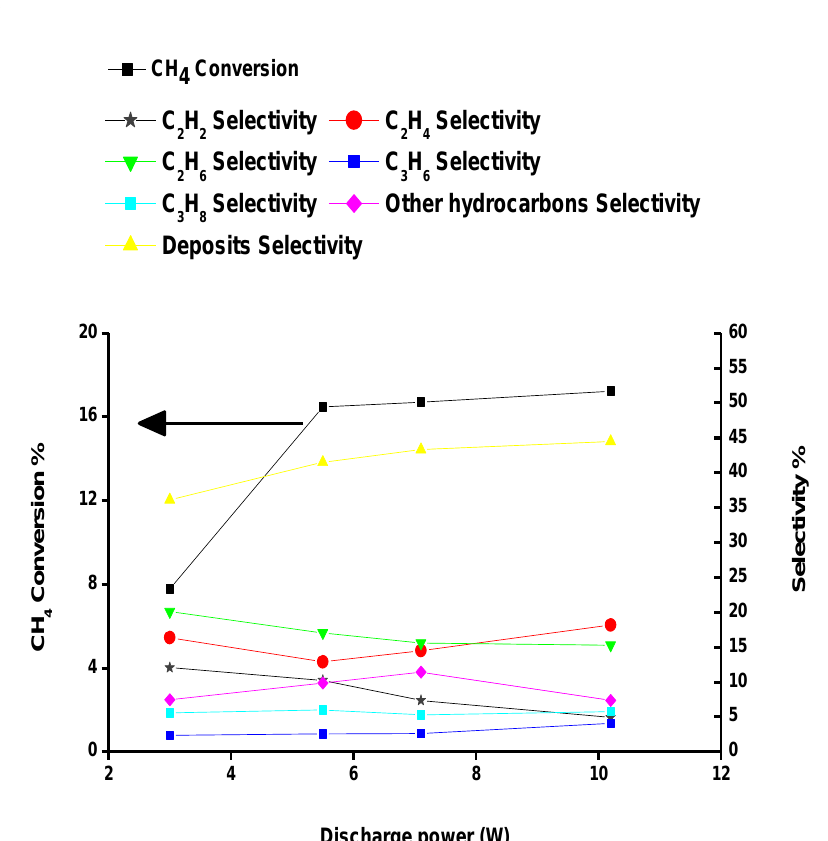
Figure 10. The effect of discharge power on the conversion of methane and the selectivity of products for the reactor packed with BaTiO 3 .